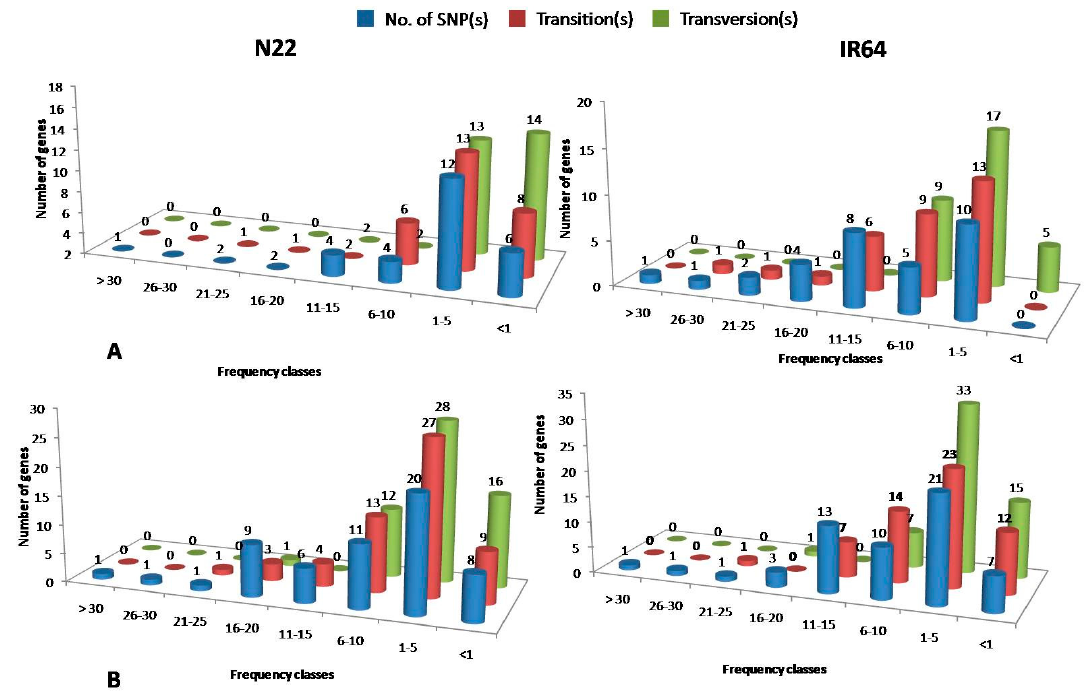
Figure 5. Frequency distribution of the genes showing SNP including transitions and transversions, observed in N22 and IR64 in the ( A ) selected QTLs for heat stress tolerance identified on chromosomes 4, 5, and 9 using recombinant inbred lines developed from N22/IR64, and ( B ) for the major hub genes identified through network analysis of the QTL-specific genes.